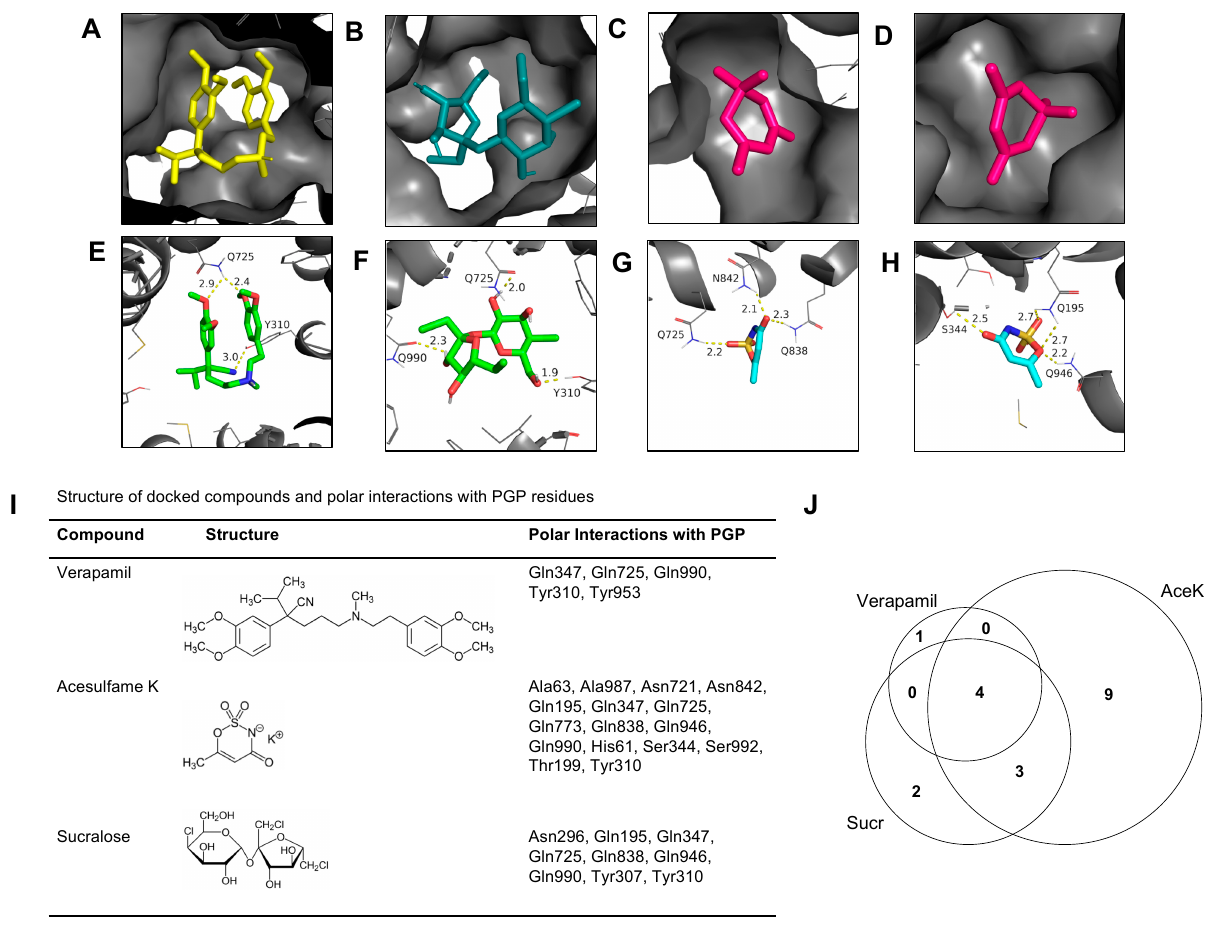
Figure 6. AceK and Sucr make similar amino acid contacts in binding pockets as known PGP substrates. ( A – D ) Select docking poses showing cartoons of Verapamil ( A ), Sucr ( B ), and AceK ( C , D ) nested in PGP binding pockets on PyMOL. PGP structure 7A65 retrieved from RCSD Protein Data Bank. Docked compounds retrieved from ZINC database. ( E – H ) Polar contacts for select poses with labeled PGP amino acid residues for Verapamil ( E ), Sucr ( F ), and AceK ( G , H ). Dashed yellow lines indicate polar bonds and bond lengths are given in Angstroms. ( I ) Structures for each docked compound are provided along with PGP amino acids residues found in polar contacts for each. In agreement with the literature on PGP substrates, residues contacted by all compounds in common include Gln347, Gln725, Gln990, and Tyr310. ( J ) Venn diagram illustrating overlaps between PGP residue polar contacts for each docked compound. Verapamil shares all but one polar contact with both AceK and Sucr. Sucr shares most polar contacts with Verapamil and AceK, with only two unique amino acid contacts. AceK has the most divergent binding profile with both the greatest total polar contacts and the most unique polar contacts.